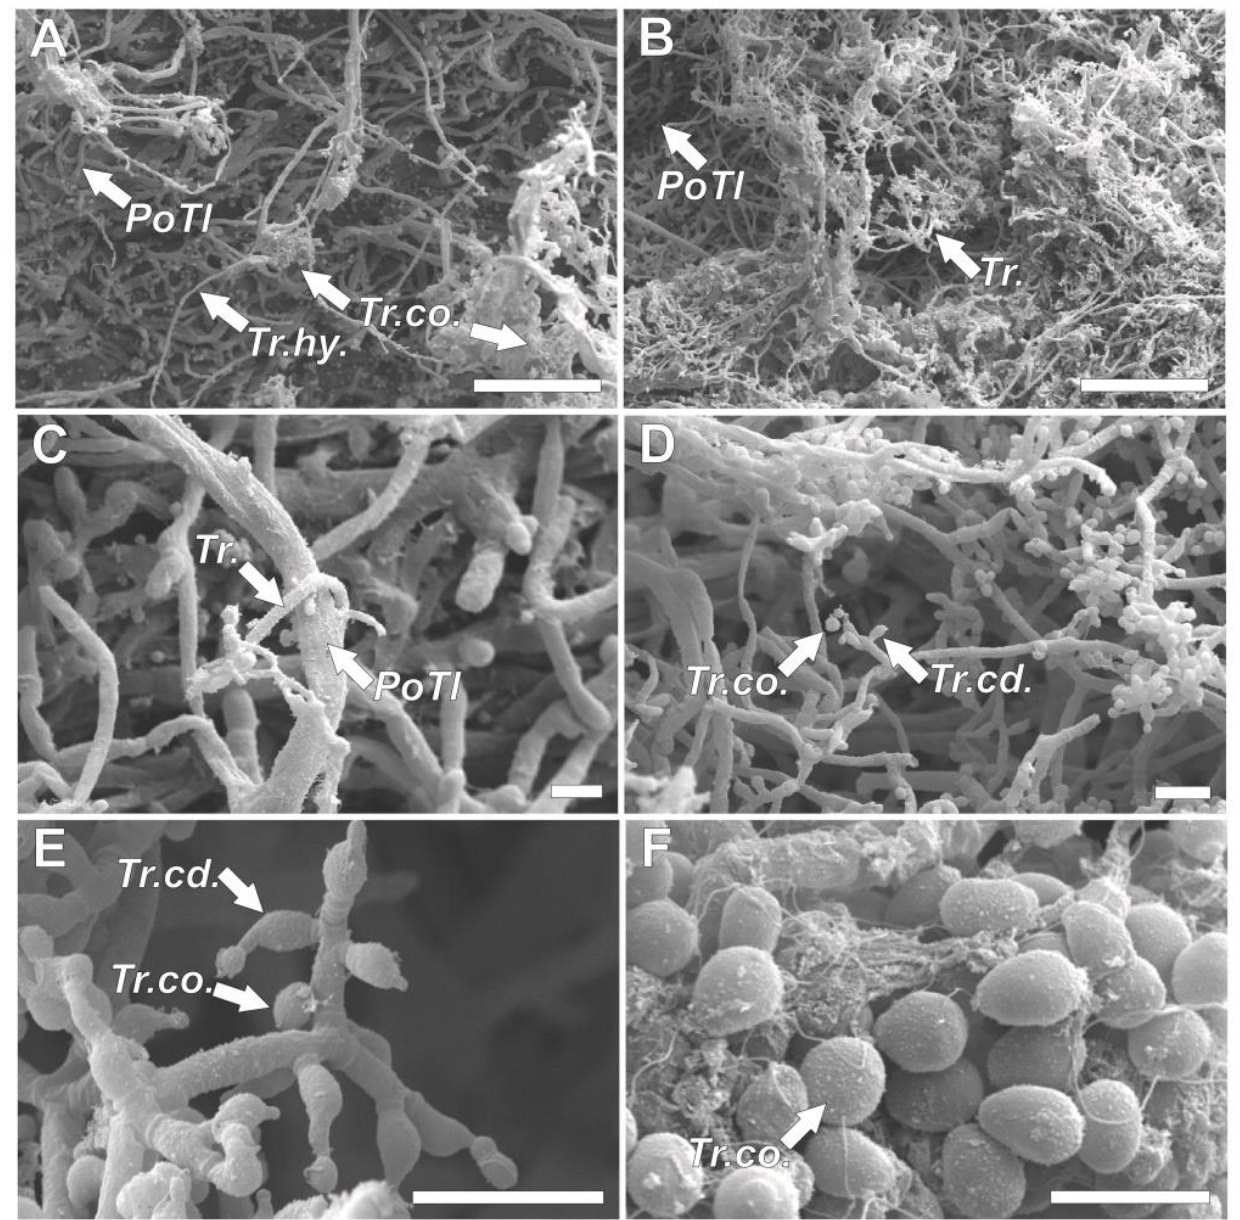
Figure 6. In vitro antagonism by the antagonistic fungus Trichoderma koningiopsis ‘Cachara’ ( Tr. ) against Pyricularia oryzae Triticum lineage ( PoTl ) on PDA medium. ( A , B ): Trichoderma hyphae ( Tr.hy. ) growth above PoTl hyphae. ( C ): Trichoderma parasitizing PoTl hyphae. ( D – E ): Trichoderma conidia ( Tr.co. ) produced from conidiophores ( Tr.cd. ). ( F ) Abundant Trichoderma conidia ( Tr.co. ) in detailed close-up. Scale bars: 100 μm ( A , B ), 10 μm ( C – E ), 5 μm ( F ).